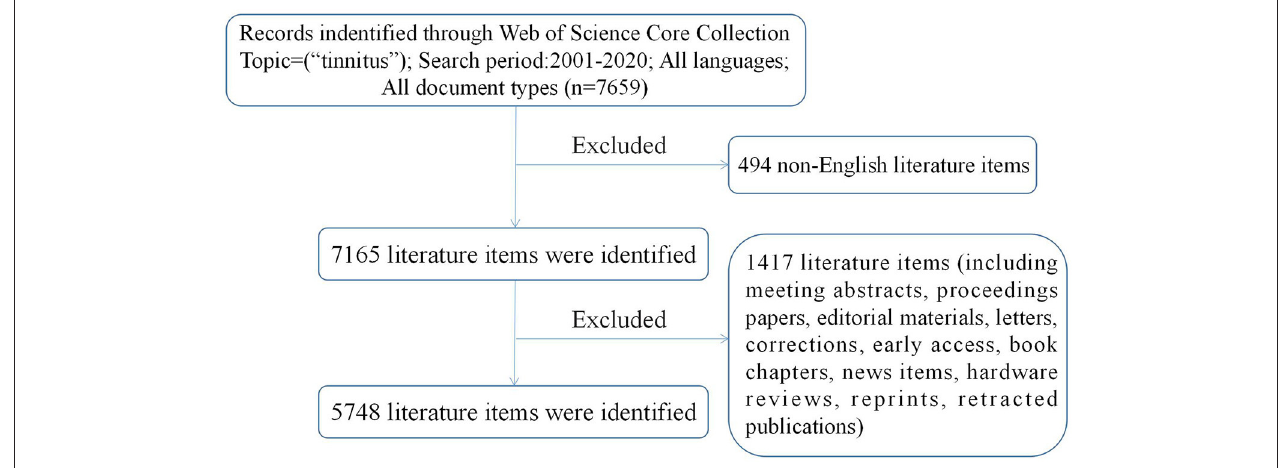
FIGURE 1 | Frame flow diagram of search